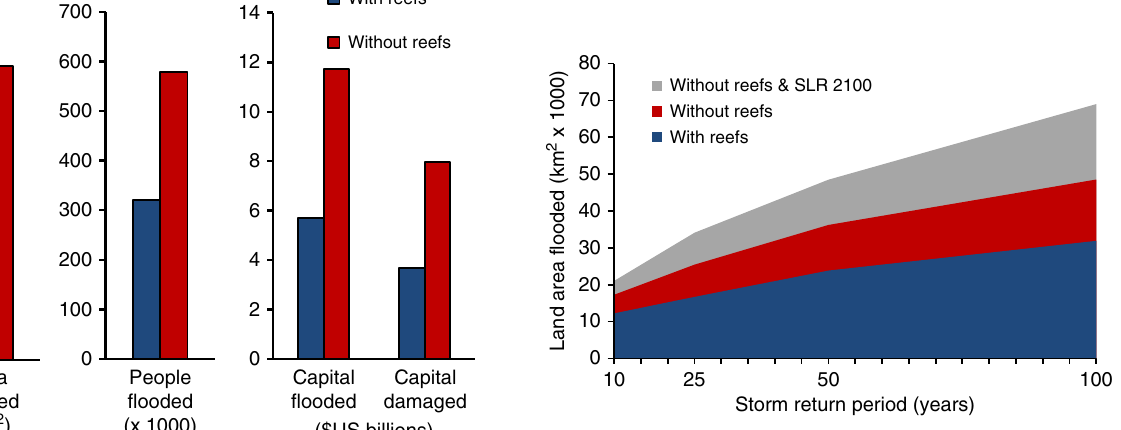
Fig. 4 The expected land protection bene fi t of coral reefs at present and with sea level rise. The values are the land areas (km 2 ) fl ooded globally with reefs at present, without the top 1 m of coral reefs and with relative sea level rise under a high emissions scenario (RCP 8.5 in 2100) by storm return